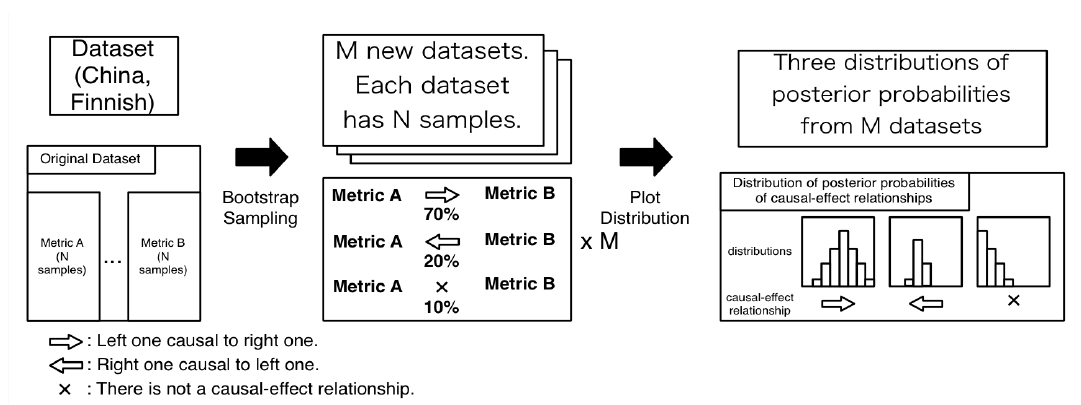
Fig. 5. Our experiment procedure for RQ2 (focusing on two